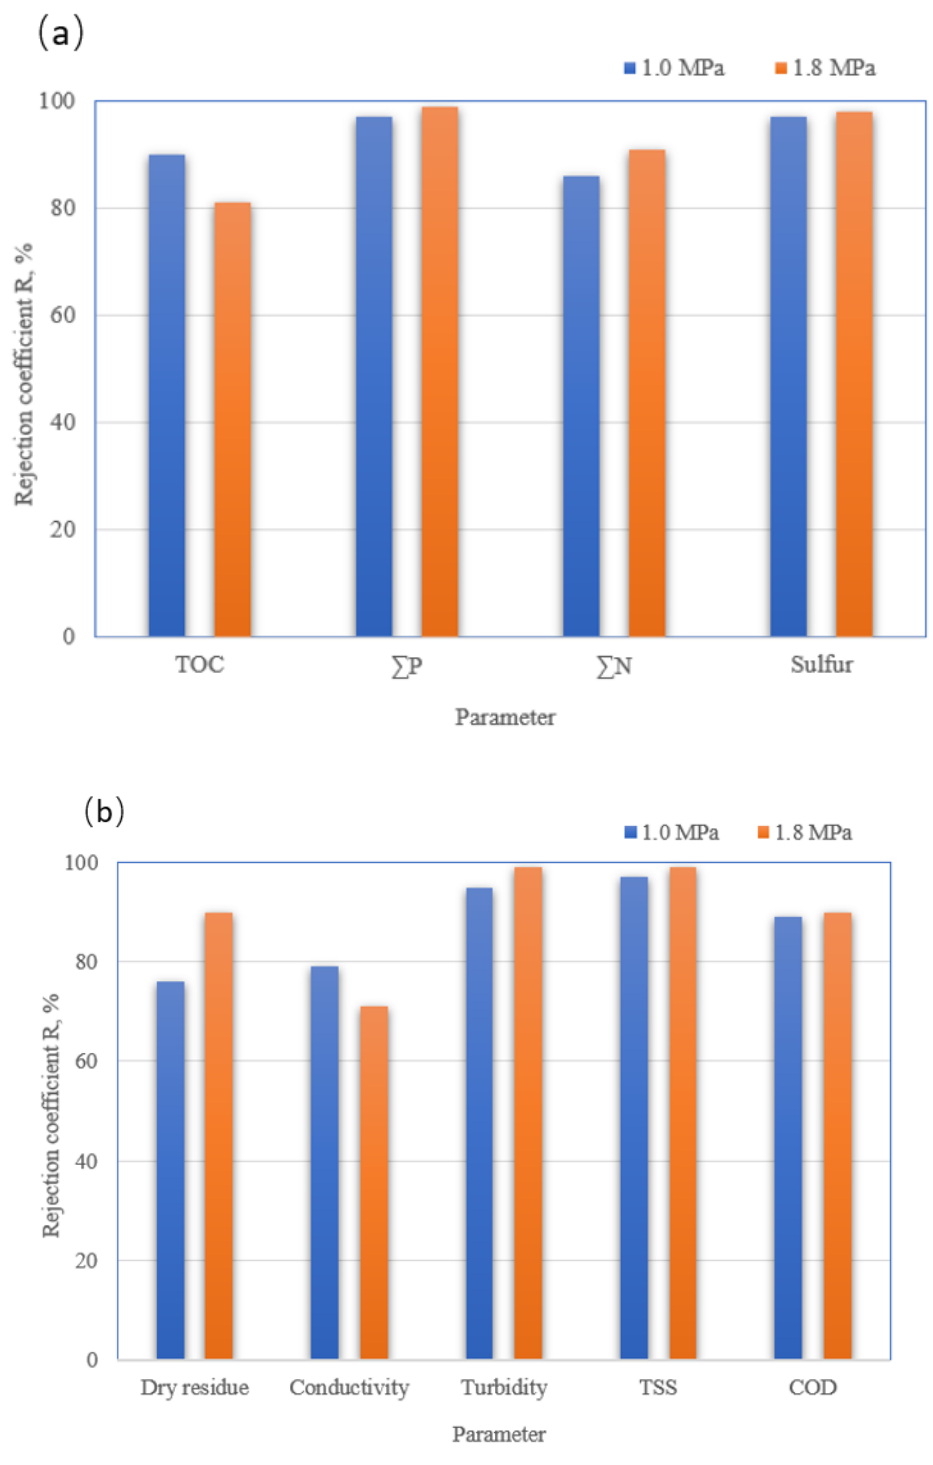
Figure 10. A comparison of rejection coefficients for determined physicochemical parameters: ( a ) TOC, ∑ P, ∑ N, and sulfur, ( b ) dry residue, conductivity, turbidity, TSS, and COD of PPW purified under operating pressure of 1.0 and 1.8 MPa.